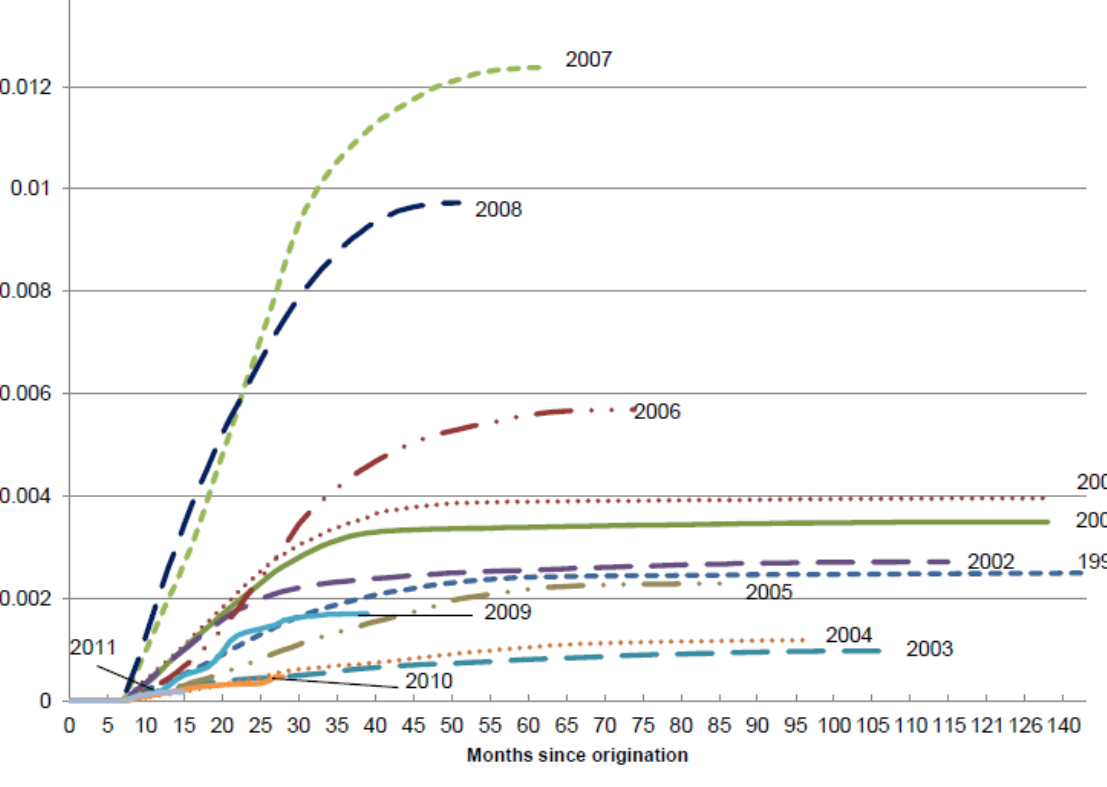
Figure 3: Put-Backs for Issuances 2000 - 2010 Source: Goodman, Laurie S., and Jun Zhu, 2013. “Reps and Warrants: Lessons from the GSEs Experience”. Urban Institute: Housing Policy Center White